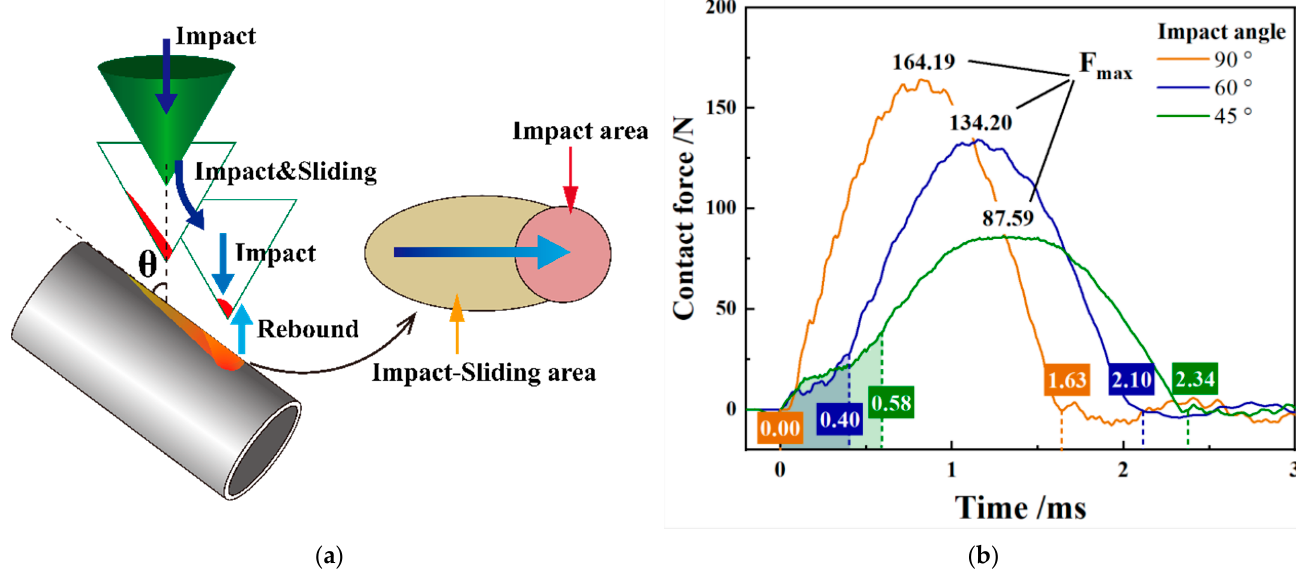
Figure 8. Wear statistics of the worn area under varying initial impact velocities. ( a ) Impact velocity response vs. time; ( b ) impact contact force vs. time.